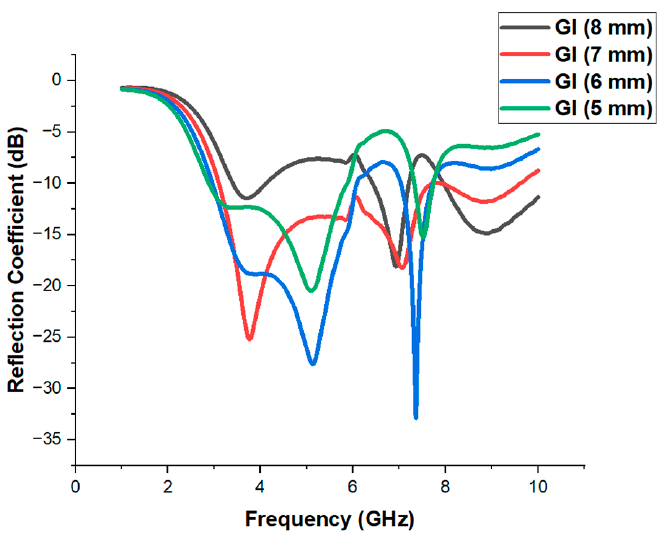
Figure 6. Parametric analysis of rectangular patch antenna with two V − shaped extrudes using DGS: return loss plot.